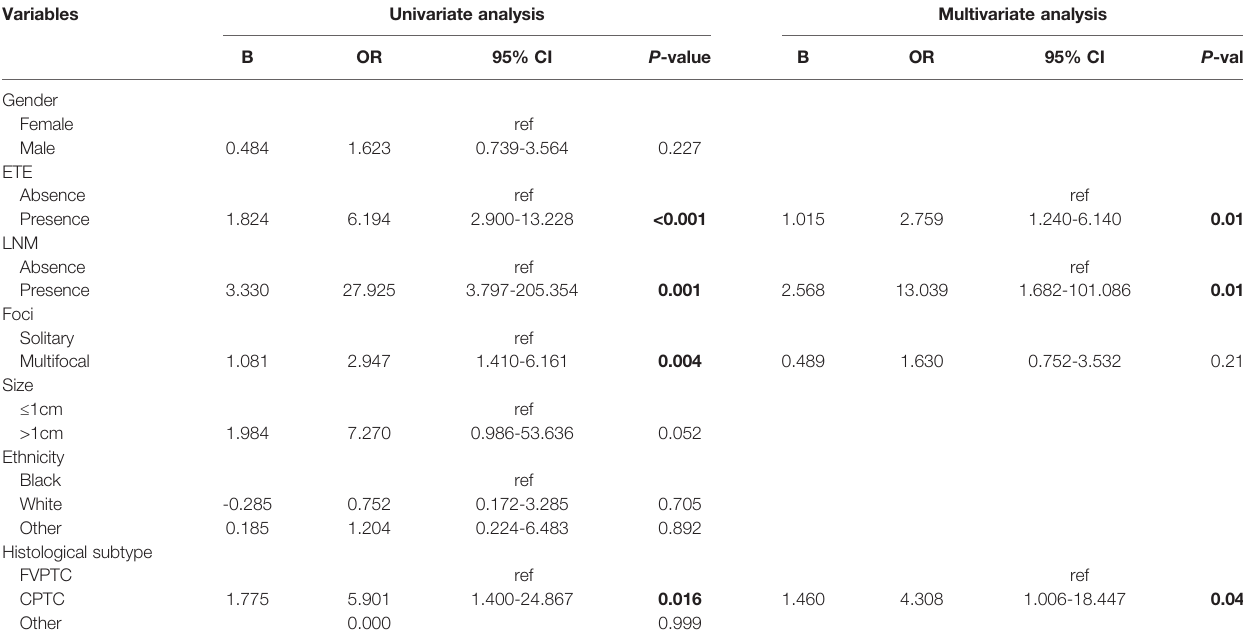
TABLE 5-1 | Risk factors of distant metastasis in pediatric patients aged 2-16 years calculated by logistic regression models.